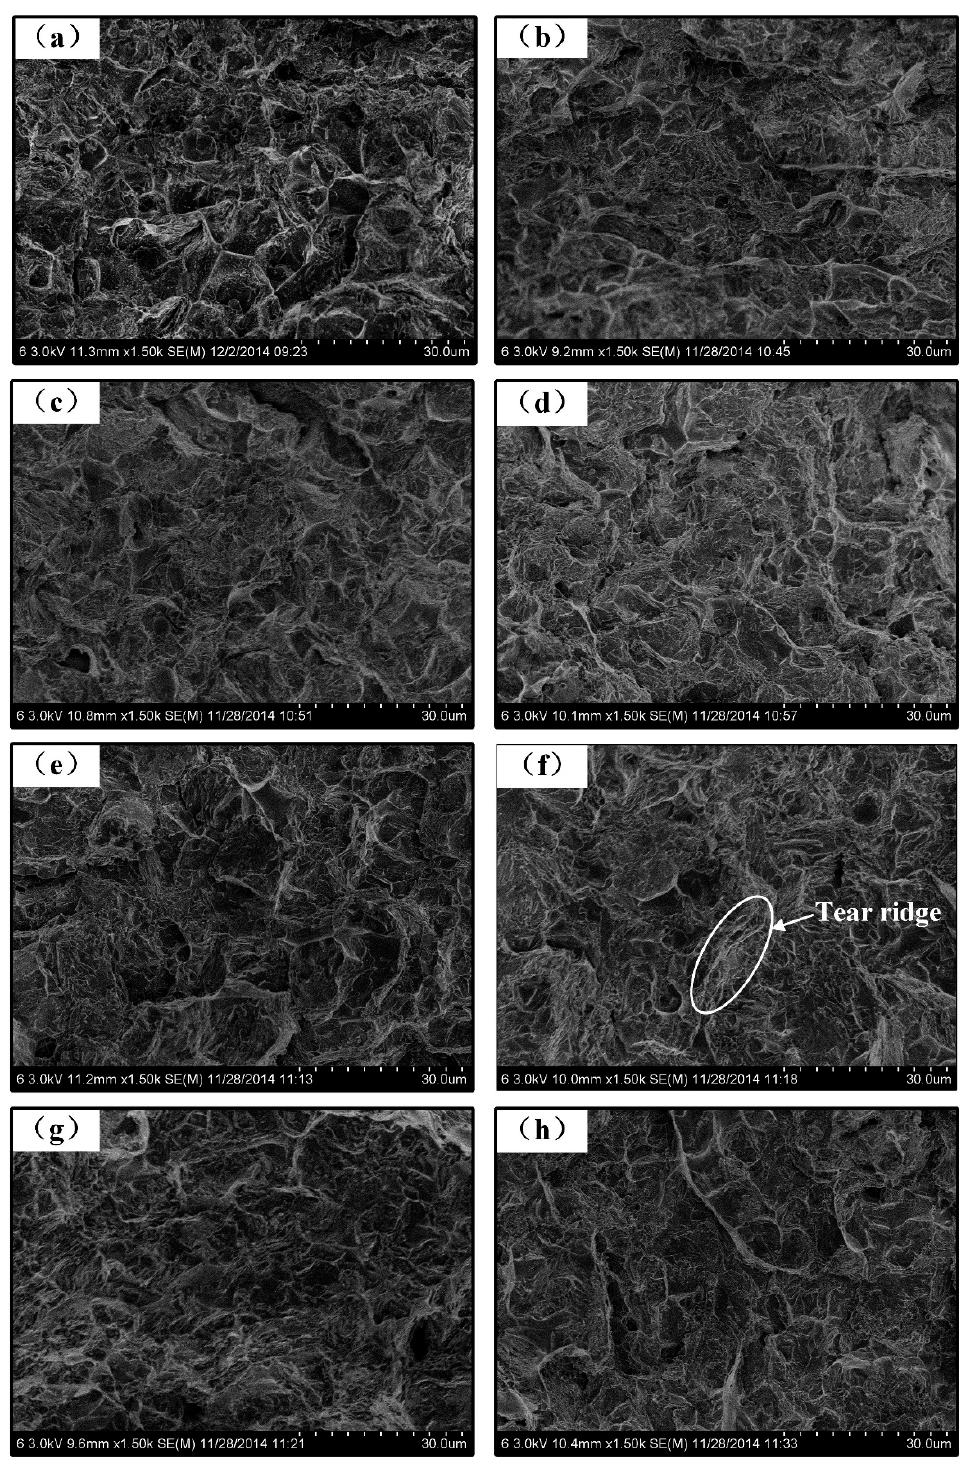
Figure 13. ( a – h ) SEM fracture surface welded by ( a ) AC CMT and ( b ) AC CMT coupled with the frequency of 20 kHz, ( c ) 30 kHz, ( d ) 40 kHz, ( e ) 50 kHz, ( f ) 60 kHz, ( g ) 70 kHz, and ( h ) 80 kHz, respectively.